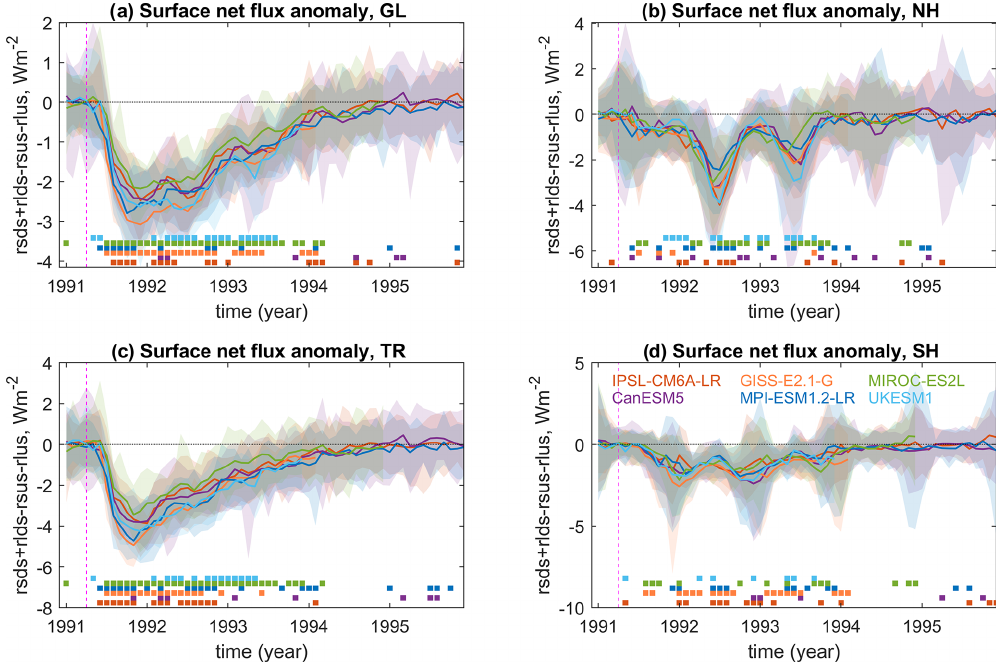
Figure 5. Surface net vertical radiative flux anomalies in the volc-pinatubo-full multi-model ensemble for (a) global (GL), (b) Northern Hemisphere extratropical (NH), (c) tropical (TR) and (d) Southern Hemisphere extratropical (SH) mean. The net flux anomalies are calculated as downward shortwave (rsds) plus downward longwave (rlds) minus upward shortwave (rsus) minus upward longwave radiation (rlus). For each model, the shading illustrates the ensemble envelope, and the line indicates the ensemble mean. Positive anomalies indicate increased downward flux. Squares at the bottom indicate when one model output is significantly different ( p < 0 . 05) from the ensemble members of all the other models according to the Mann–Whitney U test. The vertical dashed magenta line indicates the approximate timing of the eruption.